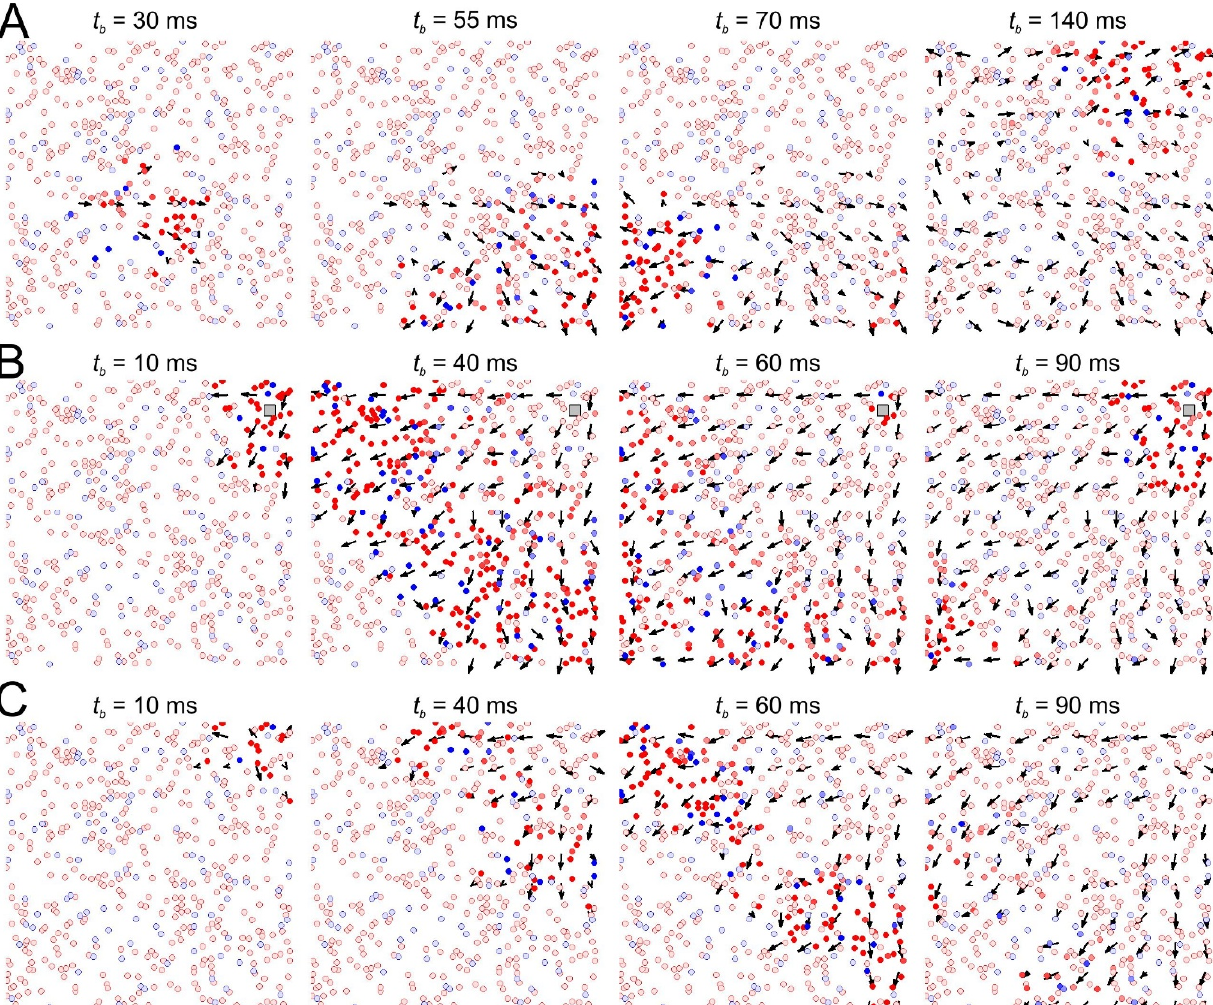
Figure 2. Emergence of traveling patches of neural activity and their relation with the vector field of functional connections (black arrow). ( A ) Spontaneous firing before stimulation (red and blue circles mark excited excitatory and inhibitory neurons, respectively; the time instants t b of the network burst refers to the interval past from the stimulus onset). ( B ) Network activity during periodic local stimulation. ( C ) Spontaneous activity after long-term stimulation.